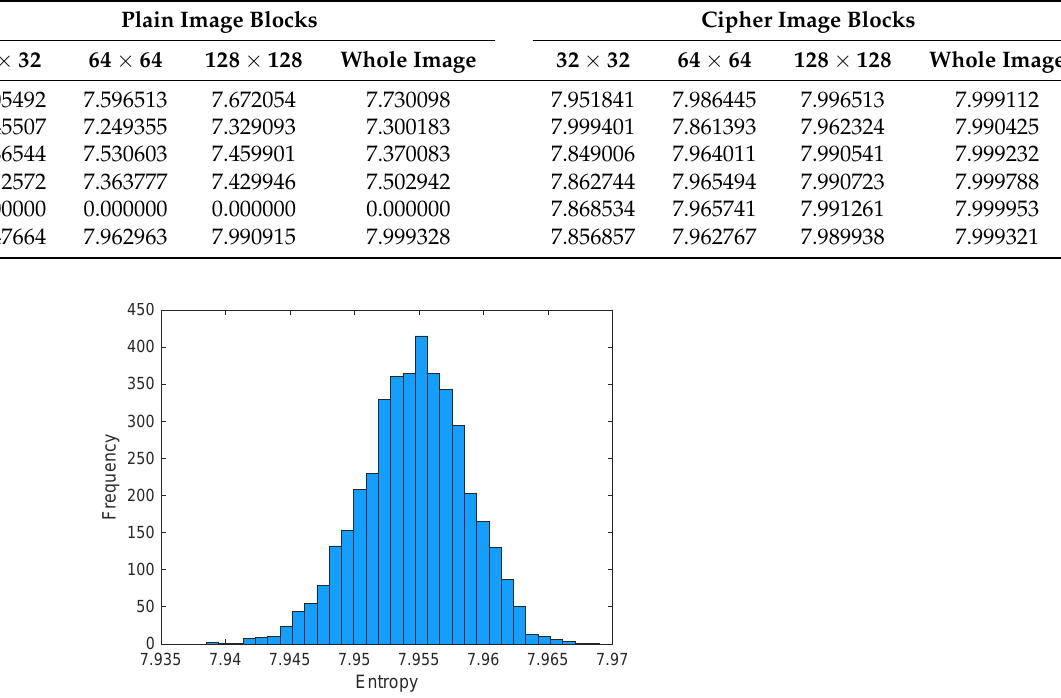
Figure 9. Entropy histogram of 64 × 64 blocks of a cipher image generated using the proposed scheme from a 4096 × 4096 black plain